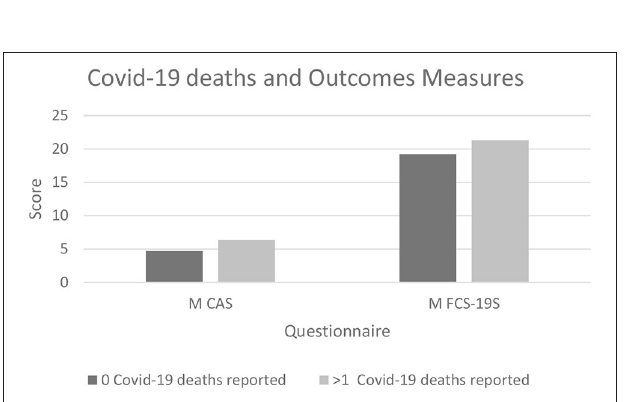
FIGURE 6 | The graph shows significantly higher CAS and FCS-19S scores in subjects who have suffered at least one loss due to COVID-19 ( p < 0.001 and p < 0.01, respectively) compared with those who did experience it. CAS, Coronavirus Anxiety Scale; FCS-19S, Fear of COVID-19 Scale; COVID-19, coronavirus disease